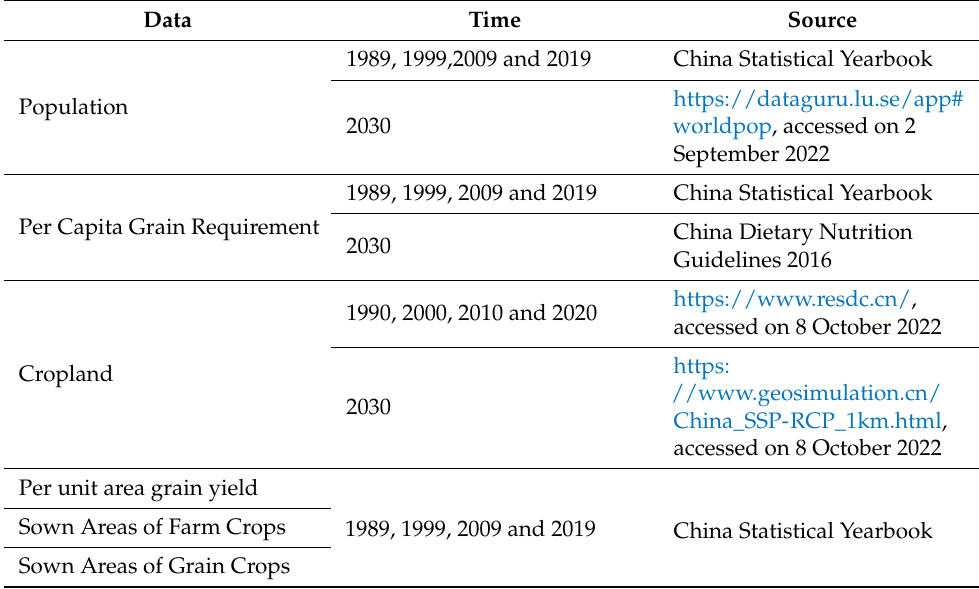
Table 3. Brief glance of data applied in this